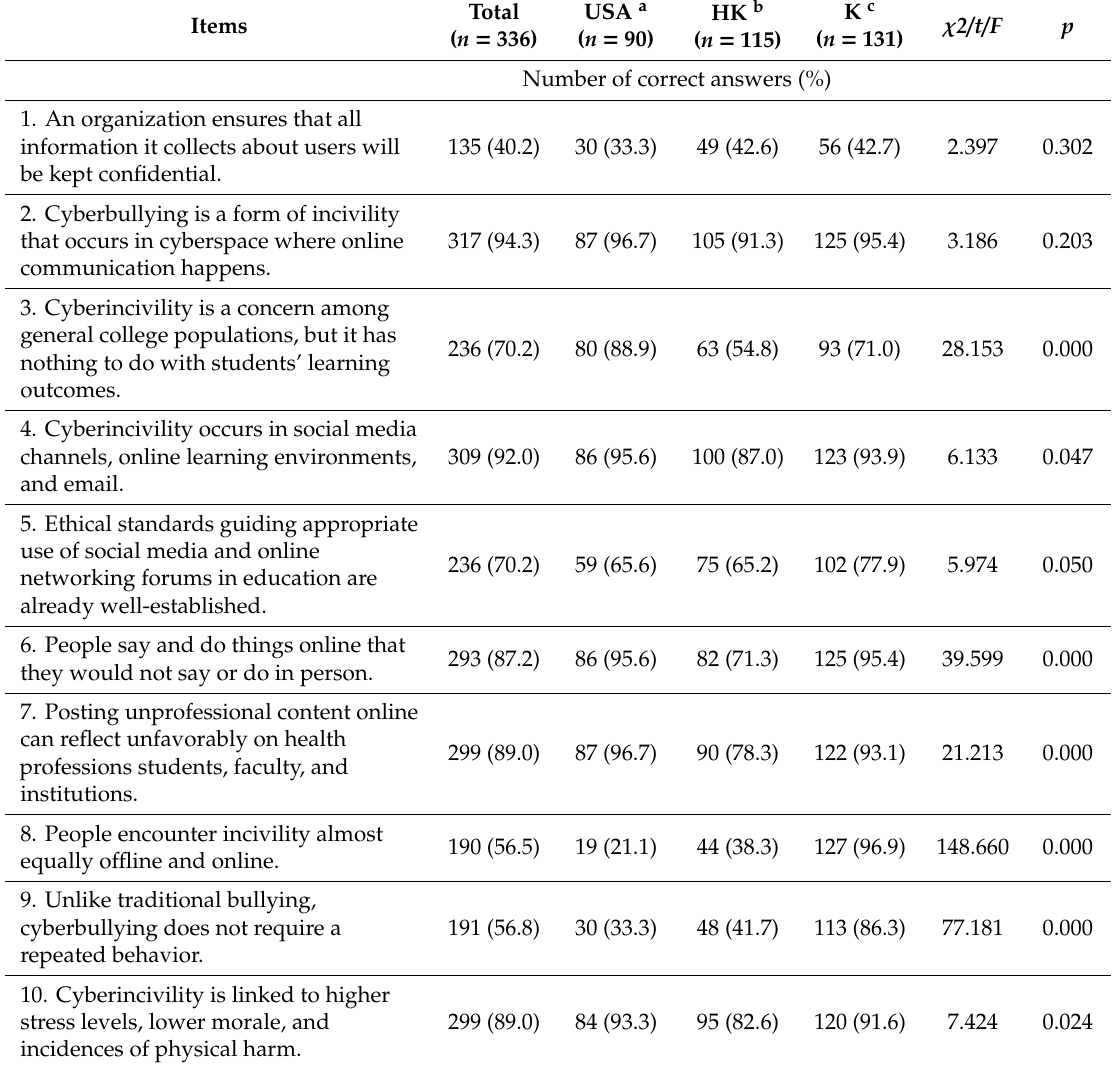
Table 2. Knowledge about